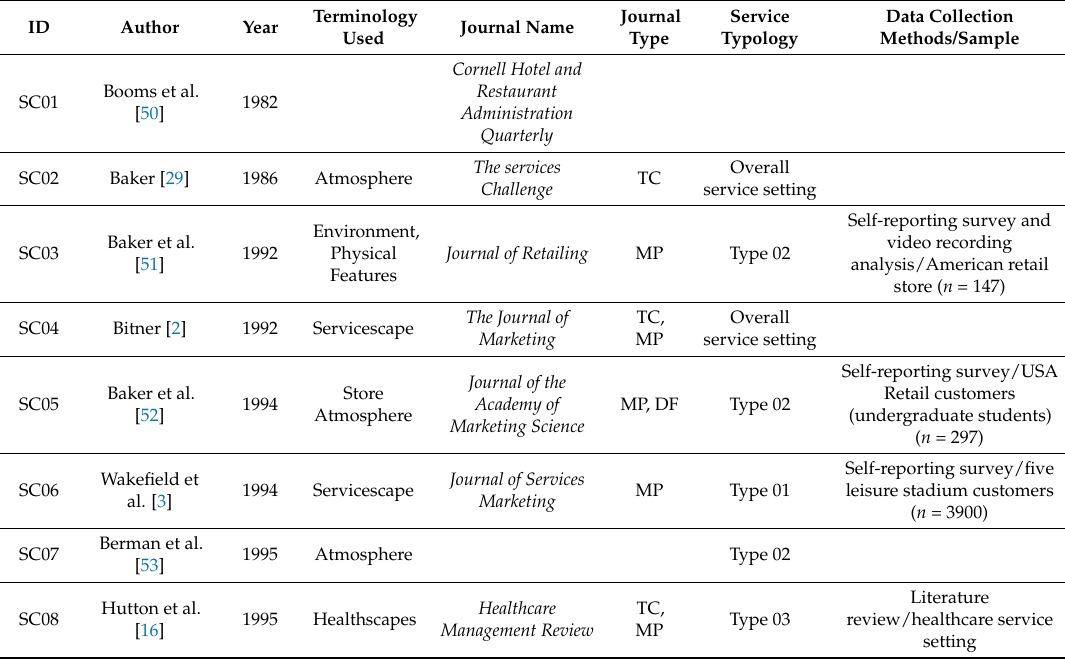
Table A1. Journals included in this